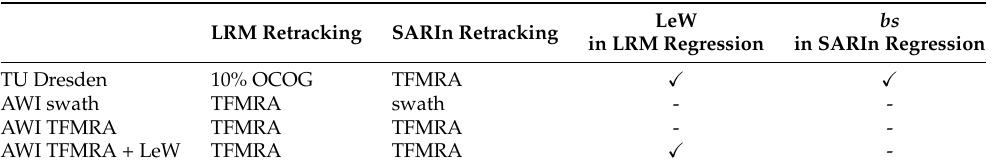
Table 5. The analysed CS-2 processing strategies with 10% OCOG [37] and TFMRA [20] retracker combinations for LRM and SARIn mode. The inclusion of the LeW and bs parameters in the regression is detailed in Equation